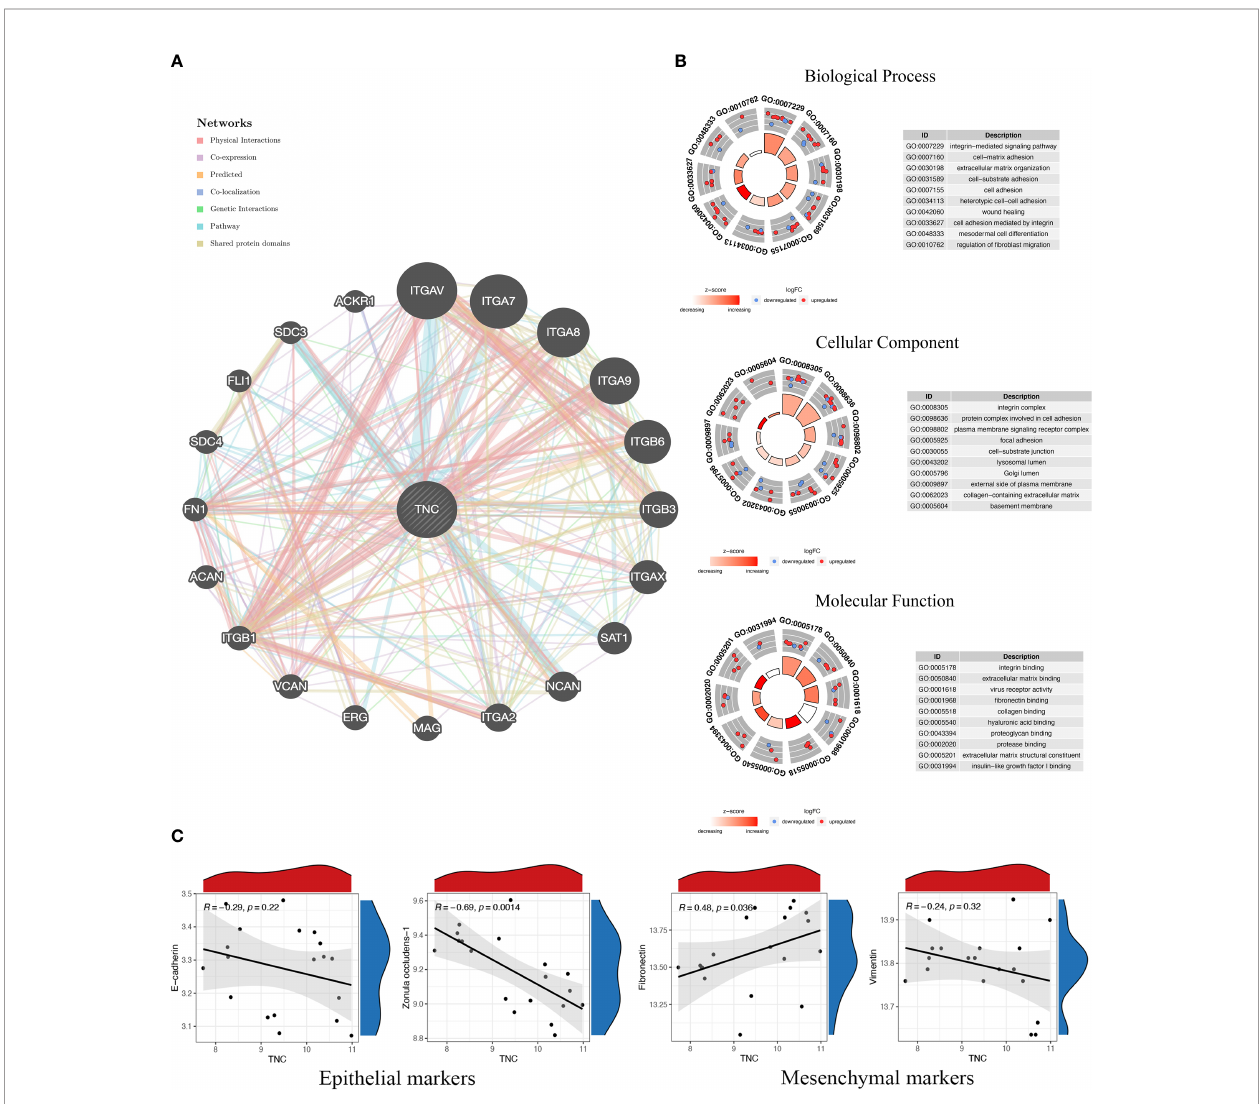
FIGURE 1 | Functional prediction of Tenascin-C and its correlation with markers of epithelial-mesenchymal transition. (A) The protein-protein interaction network of Tenascin-C and its related genes was constructed from the Genemania database. (B) The functional annotation of Tenascin-C and its related genes was performed in three parts, namely cellular component (CC), molecular function (MF) and biological process (BP). (C) The keloid dataset (GSE145725) in the Gene Expression Omnibus (GEO) database was used to perform correlation analysis of Tenascin-C with epithelial markers (E-cadherin and zonula occludens-1) and mesenchymal markers (vimentin and fi